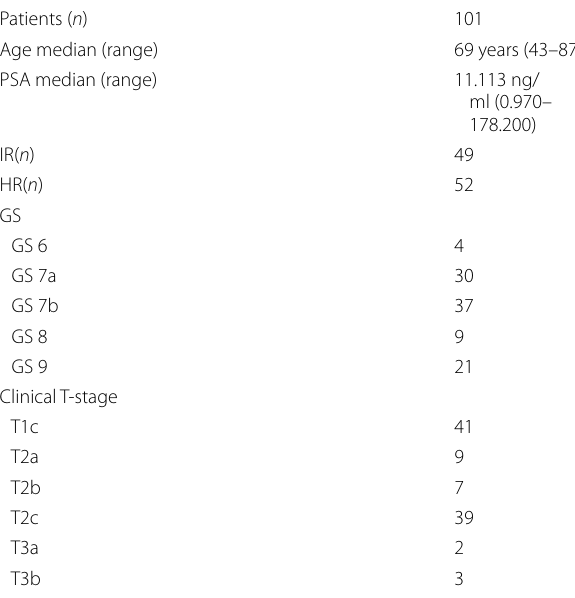
Table 3 SUVmax value of all primary prostate